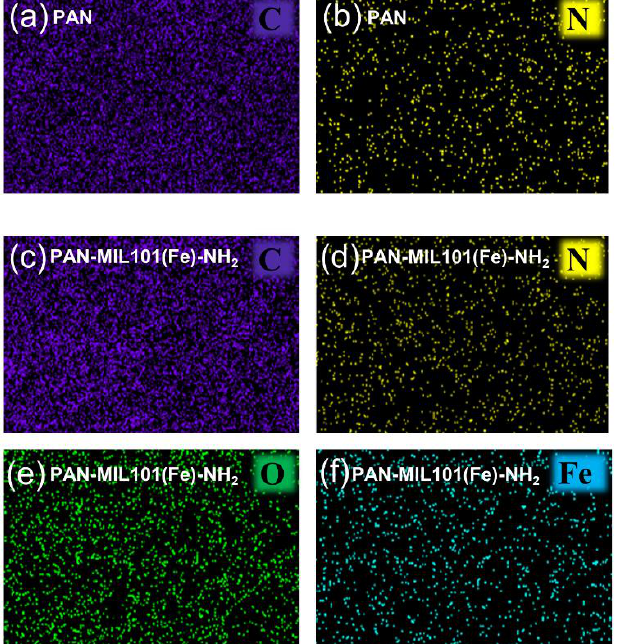
Figure 2. EDS mapping images of the PAN NFM: ( a ) C and ( b ) N; and EDS mapping images of the PAN-MIL101(Fe)-NH 2 NFM: ( c ) C, ( d ) N, ( e ) N, and ( f ) Fe.